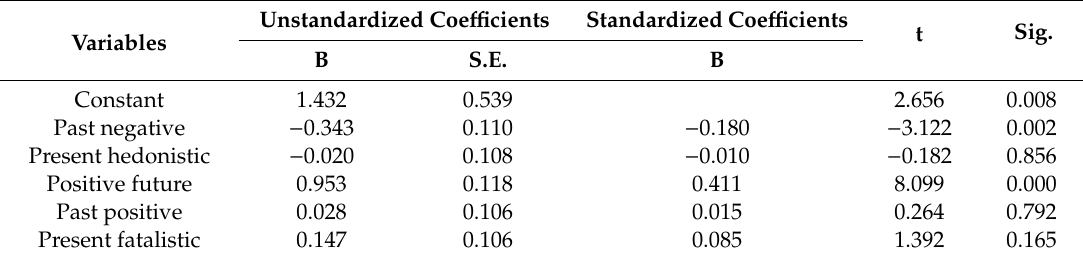
Table 5. Personality Predictors of professional e ffi